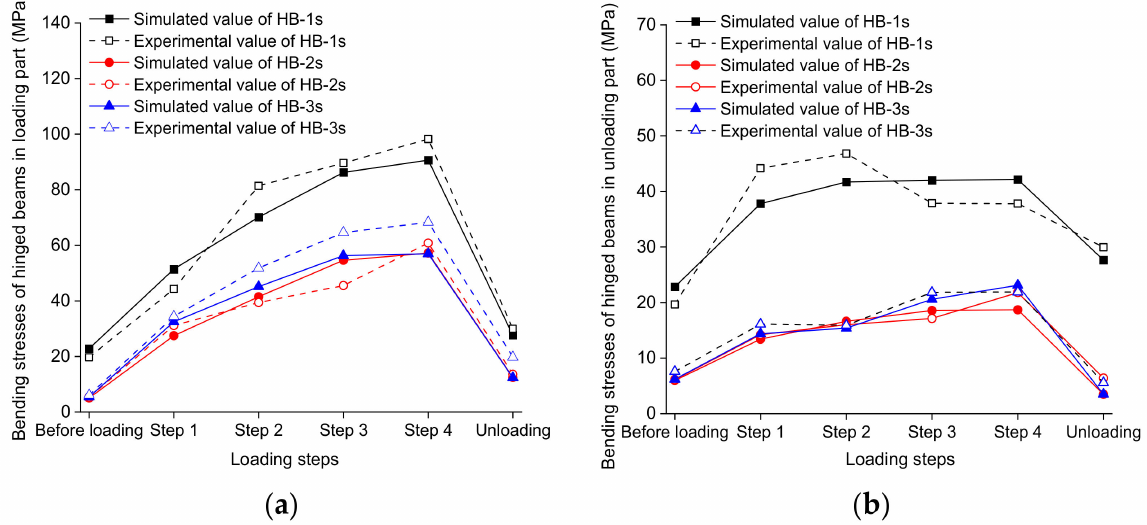
Figure 29. Bending stresses of HBs for the half-span static loading test. ( a ) Loading part; ( b ) Unloading